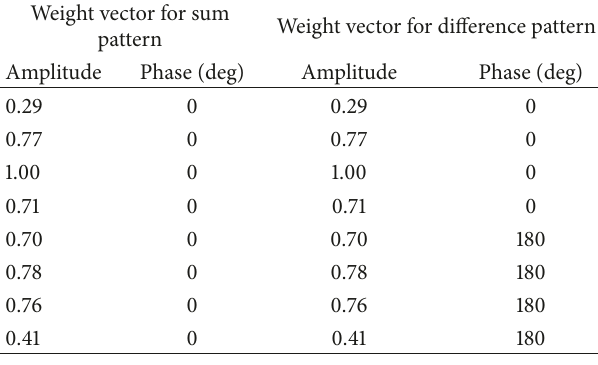
Table 2: Weight vectors used to determine the patterns in Figure 9.